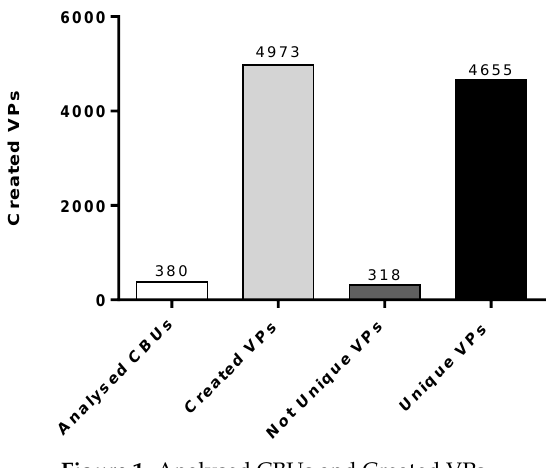
Figure 1. Analysed CBUs and Created VPs.